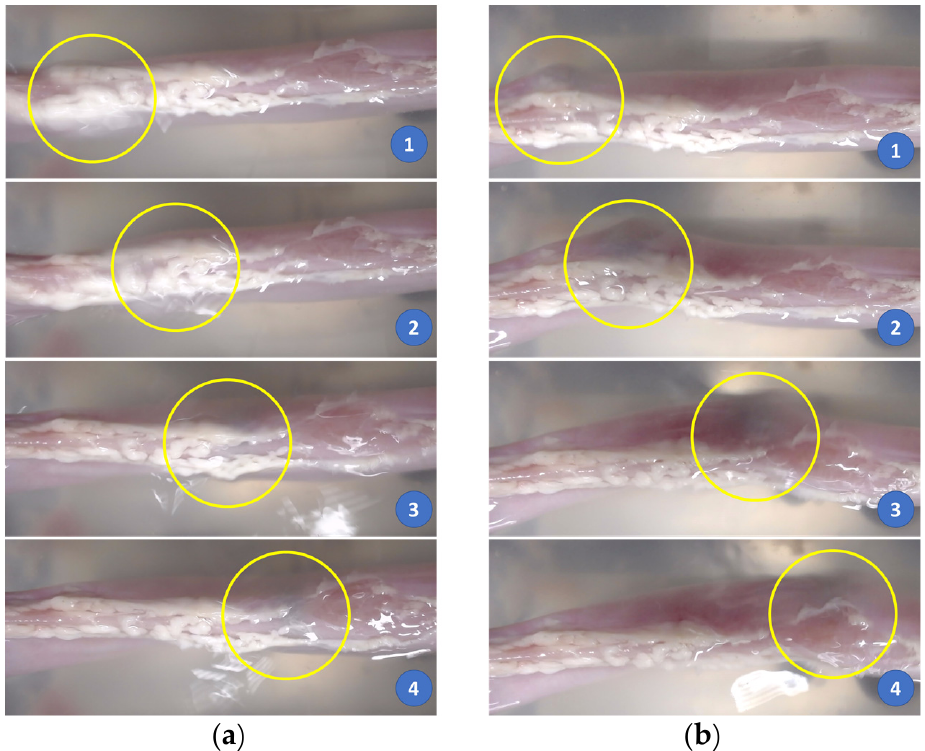
Figure 10. Movement of the CE in the water-submerged small bowel with different magnetic field gradient inputs. ( a ) Gradient field = 0.2 T/m. ( b ) Gradient field = 0.4 T/m. The yellow circle depicts the position of the CE.